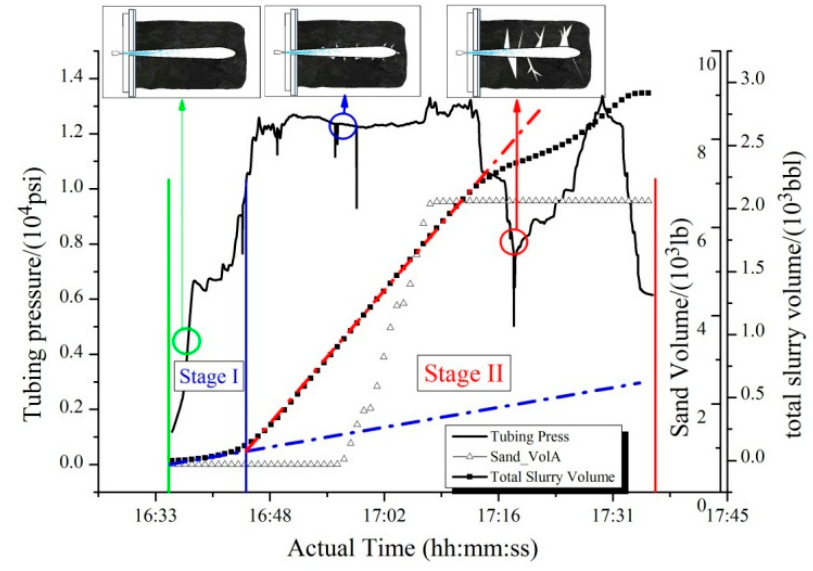
Figure 1. Schematic representation of the hydro-jet fracturing process.